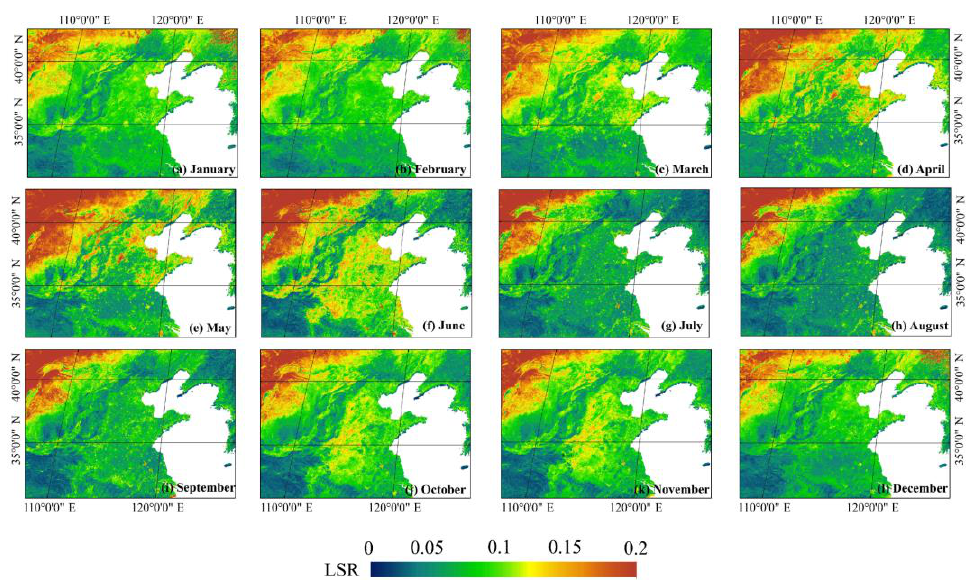
Figure 1. Monthly composite land surface reflectance images (1 km) for eastern China in the blue band (0.477 – 0.495 µm); ( a – l ) represent January – December, respectively. band (0.477–0.495 µ m); ( a – l ) represent January–December,